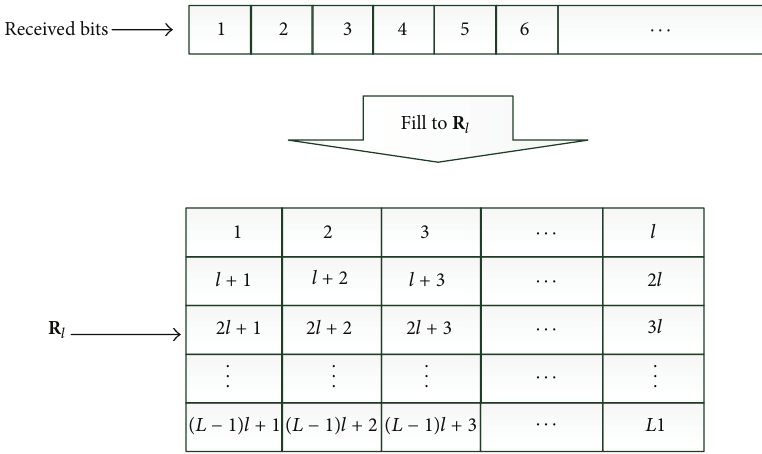
Figure 1: Generation of the observed matrix R 𝑙 .